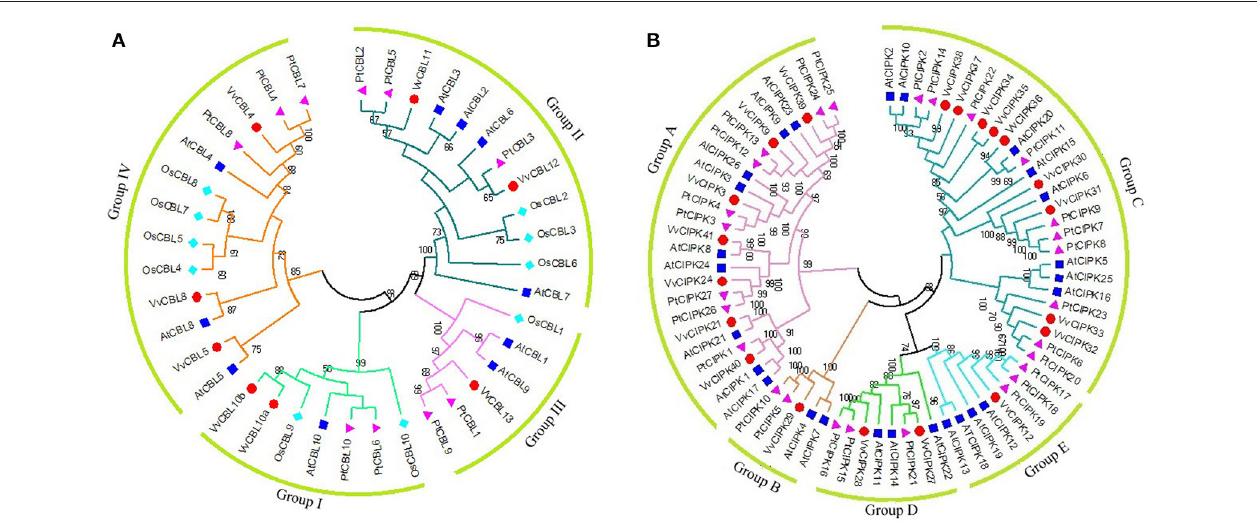
FIGURE 1 | The phylogenetic analysis of CBL (A) and CIPK (B) gene families across grapevine, Arabidopsis, rice, and poplar. Full length protein sequences of CBLs and CIPKs were used to construct Neighbor-Joining (NJ) trees by using MEGA6.0 software with bootstrap value 1,000. Subfamilies are highlighted with different colors. The grapevine CBL and CIPK genes were marked by red dots. The poplar CBL and CIPK genes were marked by purple Triangle. The Arabidopsis CBL and CIPK genes were marked by blue square. The rice CBL and CIPK genes were marked by cyan